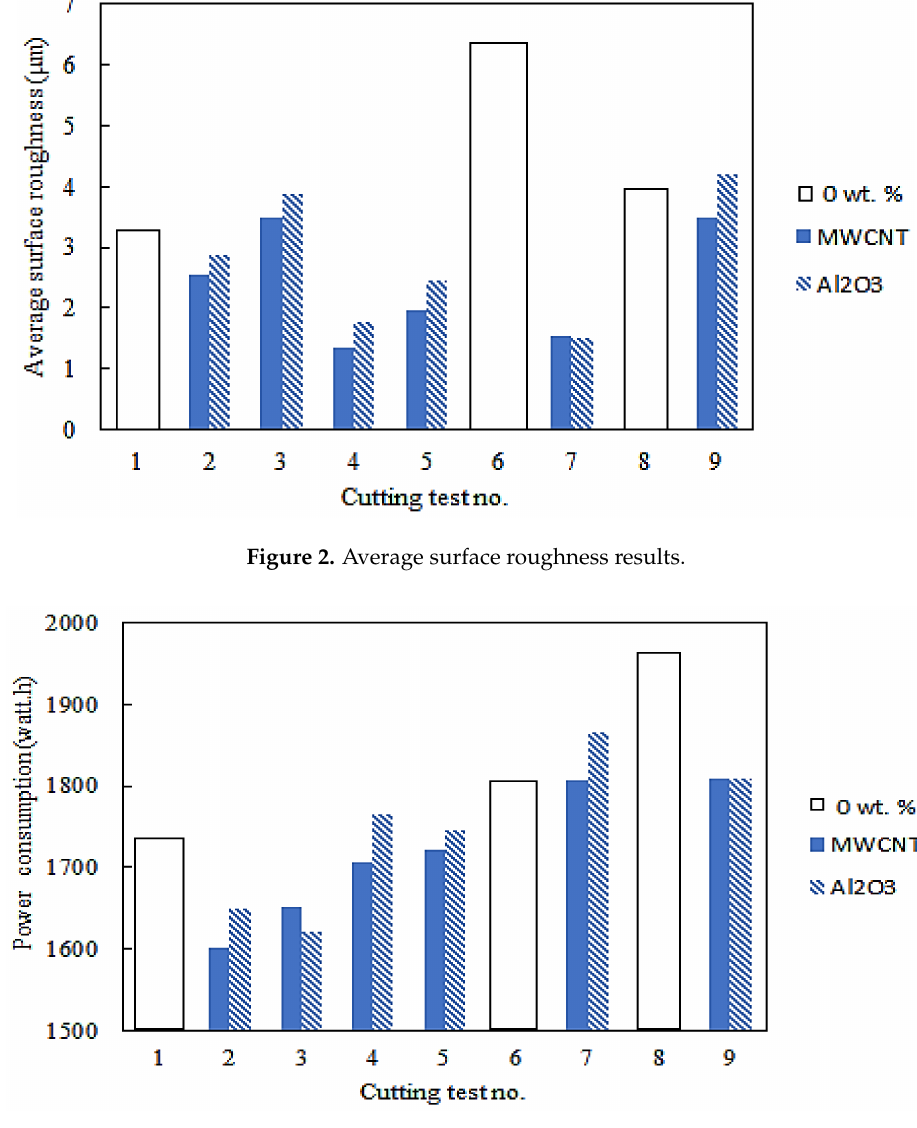
Figure 3. Energy consumption